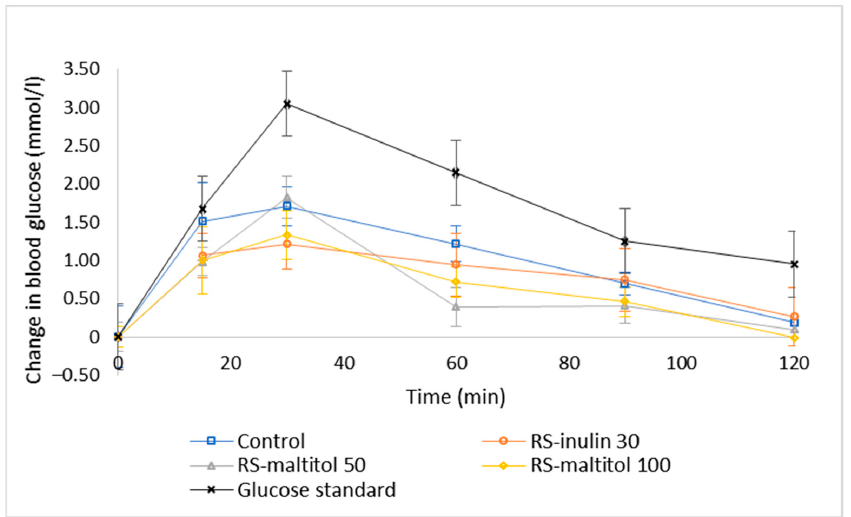
Figure 3. Temporal blood glucose levels for glucose standard and biscuit formulations. Control: biscuits made with buckwheat, sorghum and lentil flours (50:30:20) and 19% sucrose (based on total dough weight); RS-inulin 30, formulated as the Control but with part of the flours replaced by resistant starch (11.50% of total dough weight) and 30% replacement of sucrose with inulin; RS-maltitol 50: formulated as the Control but with part of the flours replaced by resistant starch (12.00% of total dough weight) and 50% of sucrose replaced by maltitol; RS-maltitol 100 as the Control but with but with part of the flours replaced by resistant starch (11.50% of total dough weight) and the total replacement of sucrose with maltitol. Data are reported as mean ± SEM (11 measurements for each biscuit sample and 11 × 3 measurements for glucose standard).